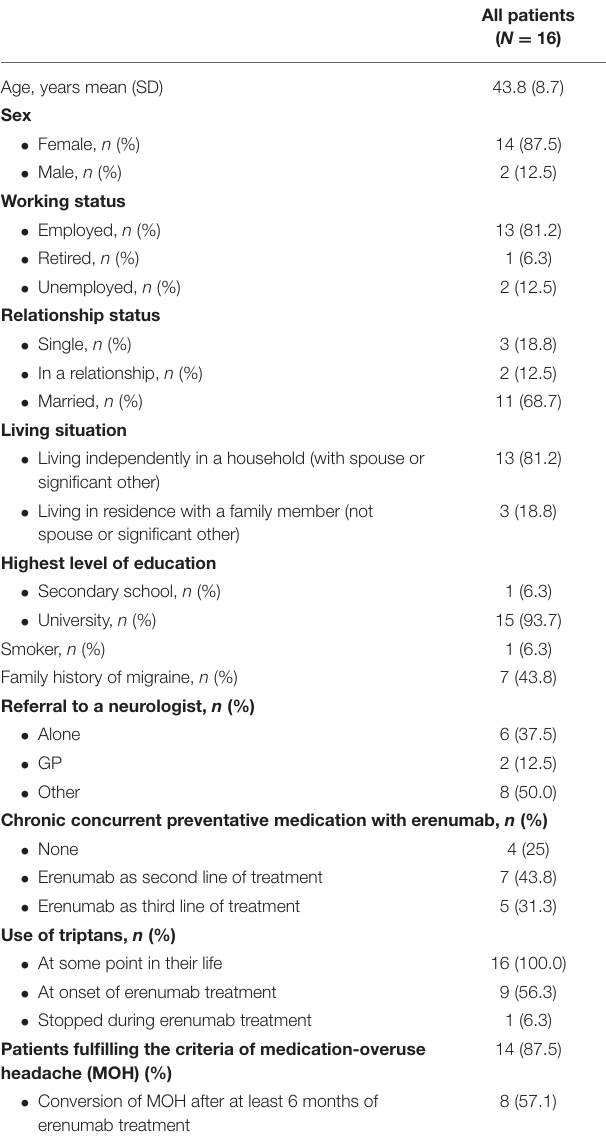
TABLE 1 | Socio-demographics and clinical characteristics of the cohort